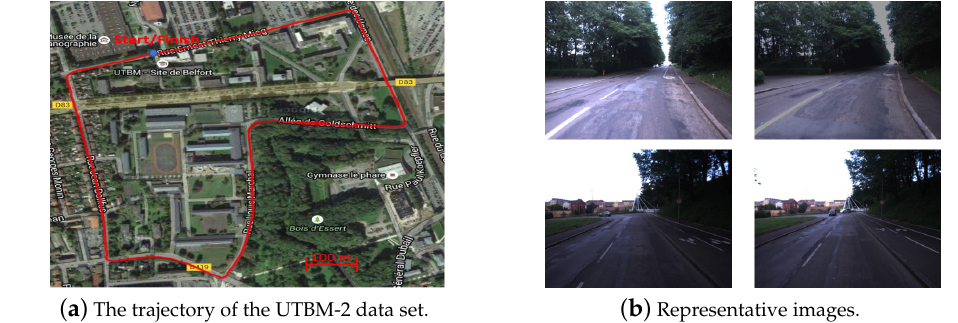
Figure 6. The trajectory of the UTBM-2 data set and its representative images: ( a ) The trajectory acrosses forest, city, and parking areas. ( b ) Two representative examples of illumination variations. The images in each row were taken in the same place at different times (morning vs.